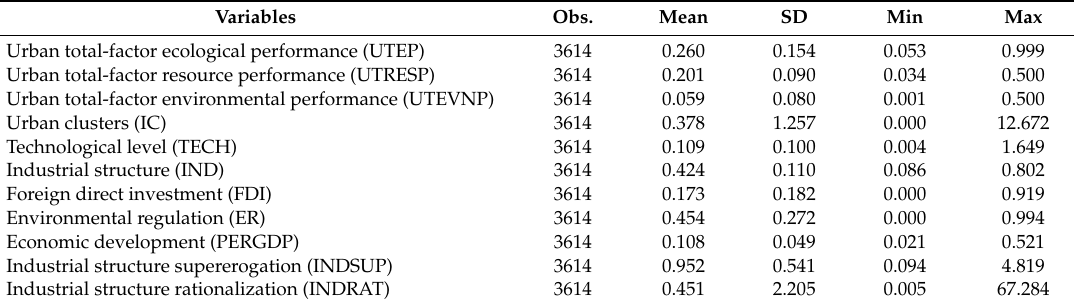
Table 2. Summary